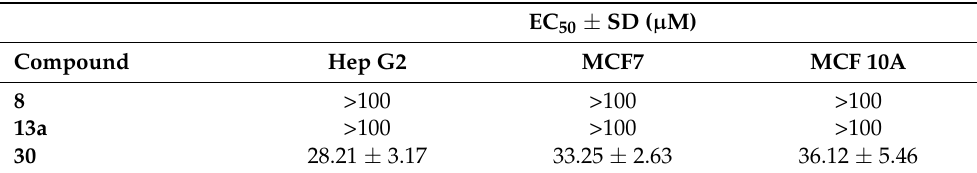
Table 1. Overview of the EC 50 results of the in vitro toxicity screening for 8 , 13a and 30 . For each compound, at least three independent experiments were performed, and the results are given as EC 50 ± SD.